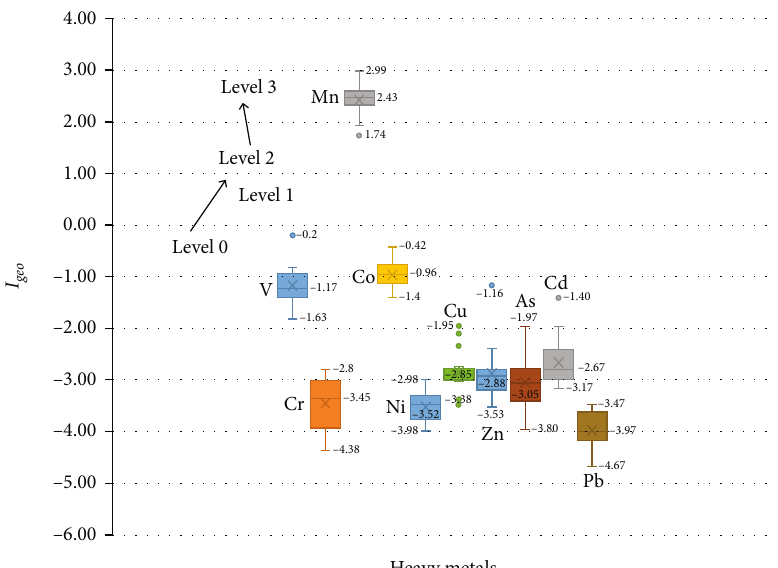
Figure 3: The box plot of I